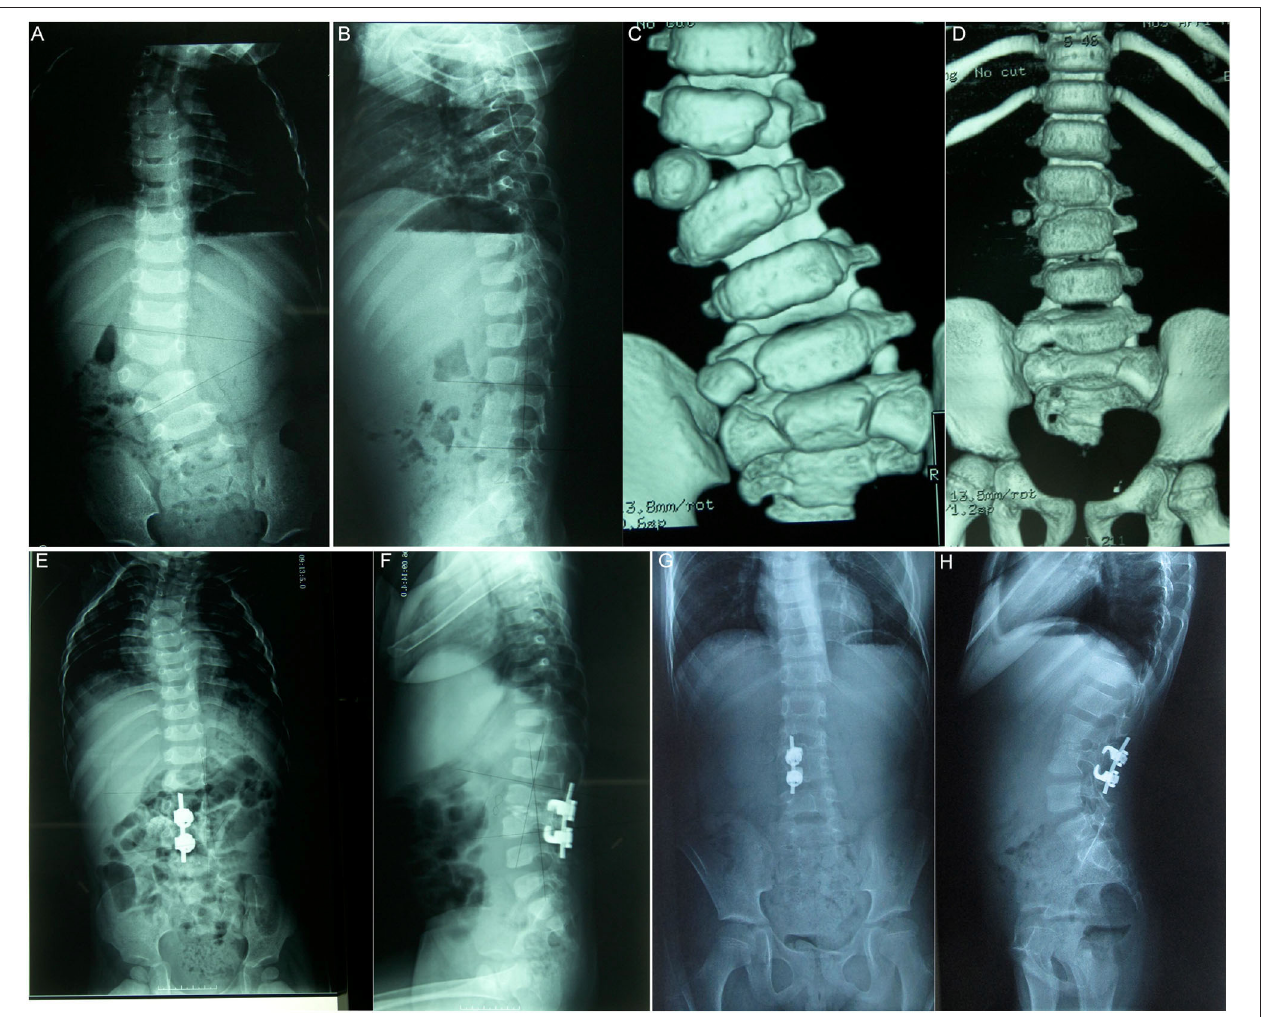
FIGURE 2 | The patient is a 20-month-old boy. The right L3 is a completely segmented hemivertebrae, and the preoperative Cobb angle of scoliosis is 35 ◦ . Hemivertebra resection via the posterior approach of grade 5 osteotomy assisted by unilateral hook rod internal fixation was performed (A–C) . Post-operative CT (D) reveals that the osteotomy space is stable, and the orthopedic effect is good. The postoperative Cobb angle of scoliosis is 7 ◦ , the orthopedic effect was good 8 years after the operation, and there was no significant loss of angle at follow-up (E,G) . The sagittal position reveals that preoperative kyphosis turns into physiological lordosis (B,F,H)